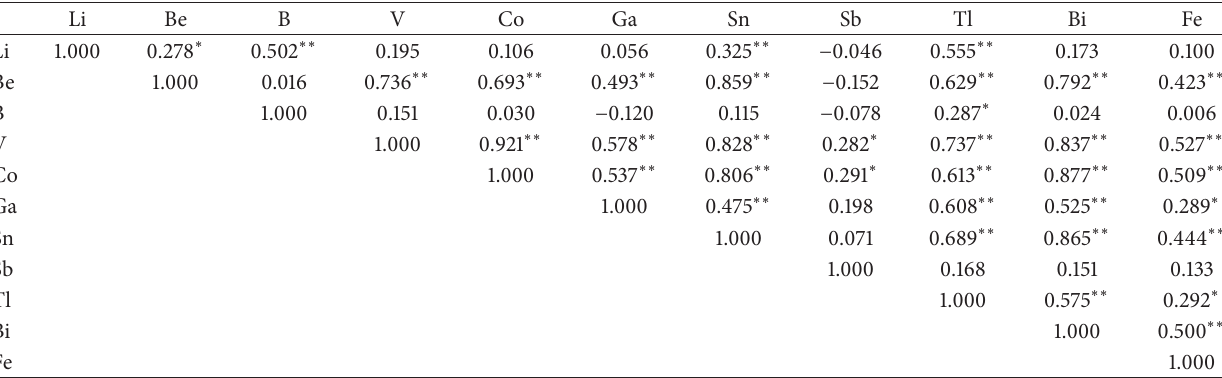
Table 5: Correlation coefficients of SMTEs in TGR